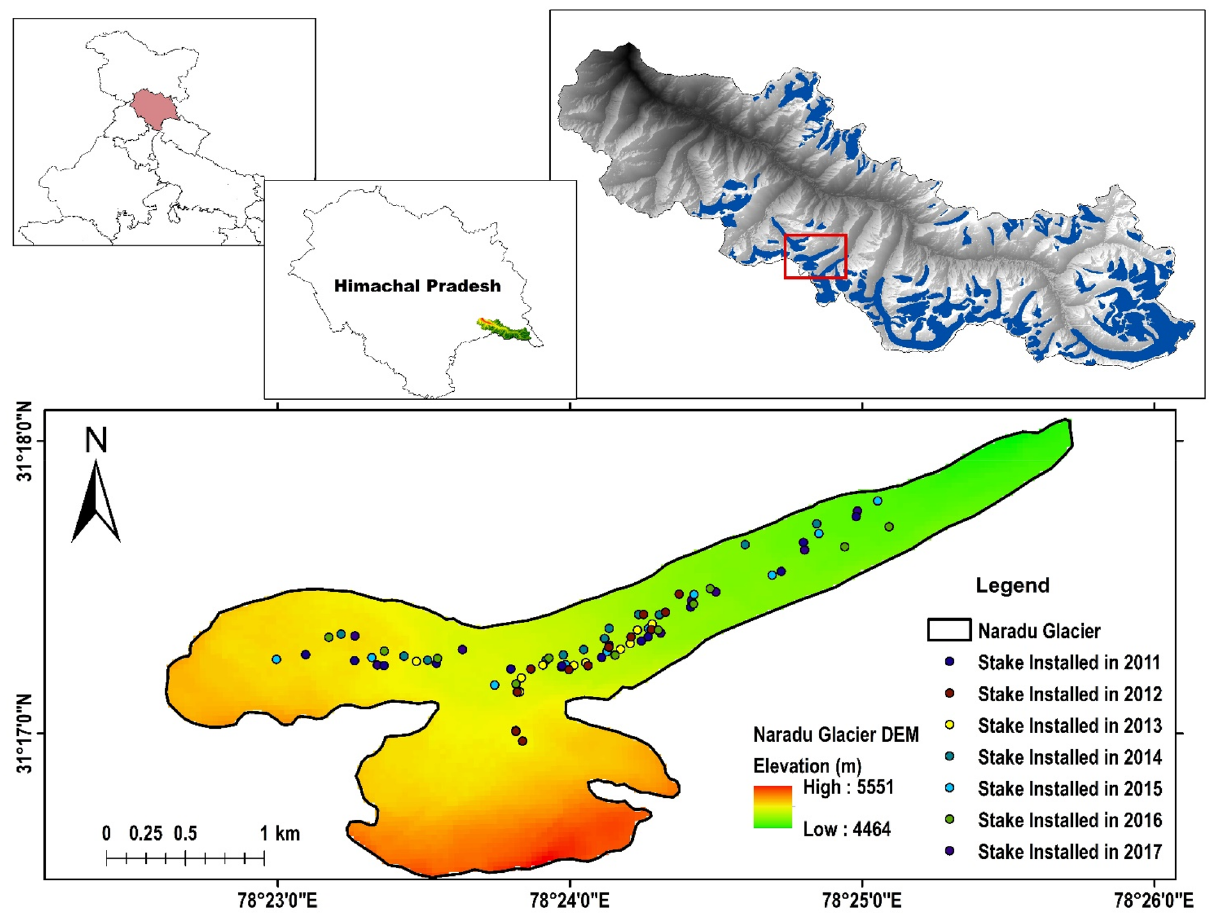
EFL691568009-1010). (courtesy- India map shapefile at http:// www. diva- gis. org/ gdata; Digital Elevation Model (DEM) download from NASA Earth Data at https:// search. earth data. nasa. gov/ search/; Naradu glacier shapefile digitized manually on Landsat 8 image acquired from USGS https:// earth explo rer. usgs. gov/ dated 19 September